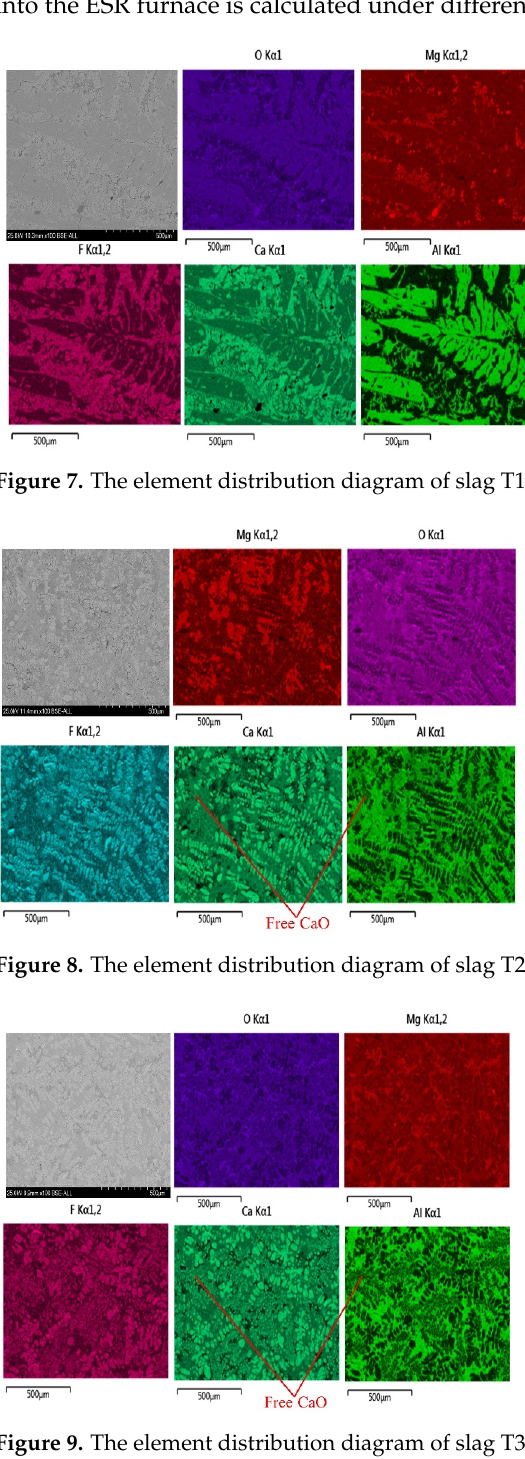
Figure 9. The element distribution diagram of slag T3 analyzed by SEM-EDS.